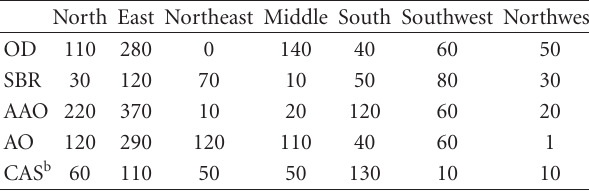
Figure 2: Composition of processes in municipal WWTPs in China. Table 1: Capacities of WWTP processes in geographic zones of China in 2006 a